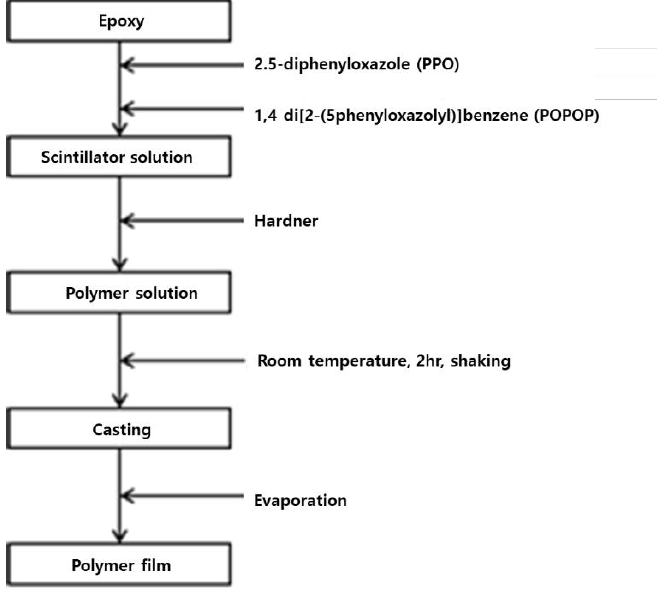
Figure 6. Plastic scintillator manufacturing procedure [32].